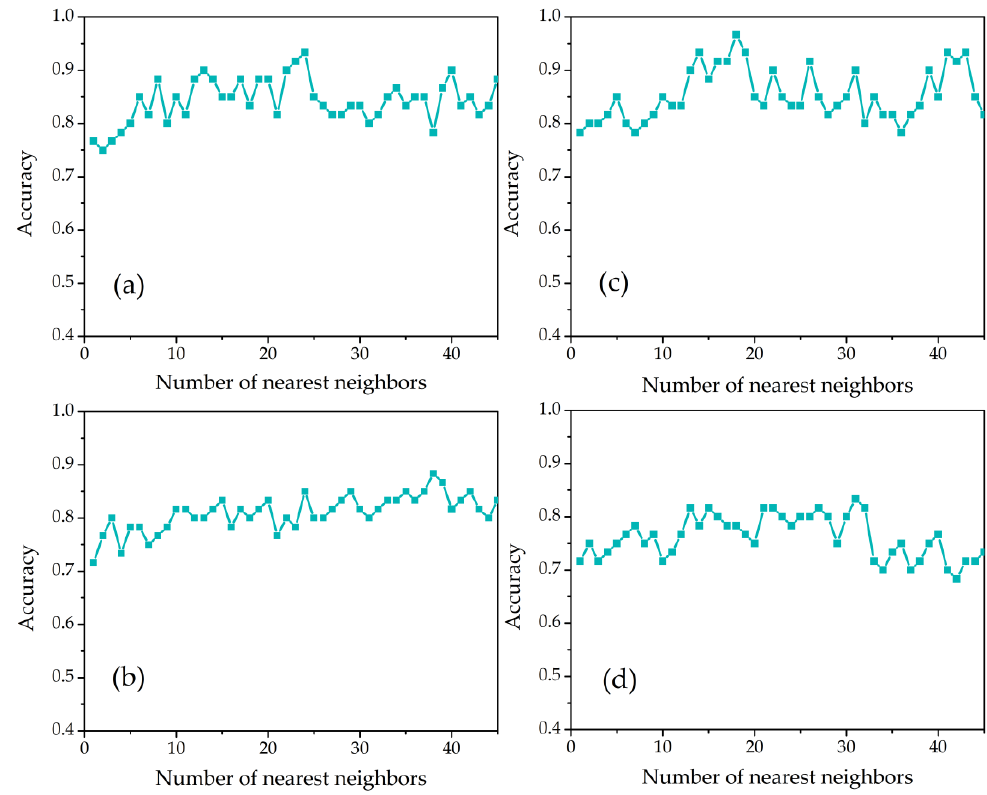
Figure 6. Classification accuracies of the number of nearest neighbors parameter variation in SVM combined with ( a ) LTSA, ( b ) LLE, ( c ) Isomap, and ( d ) LE.